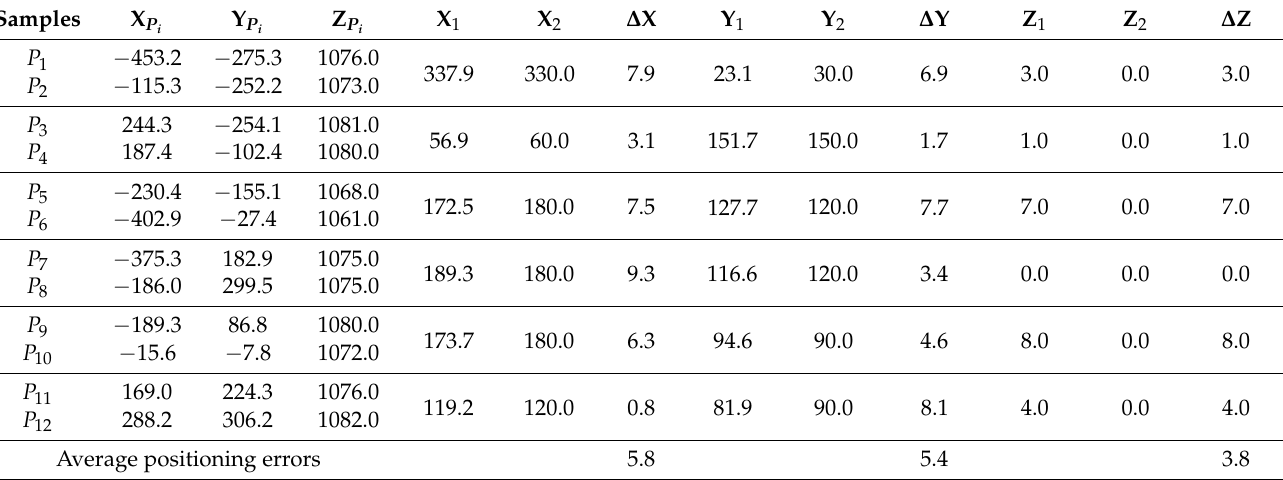
Table 5. Error statistics between predicted and true positions.